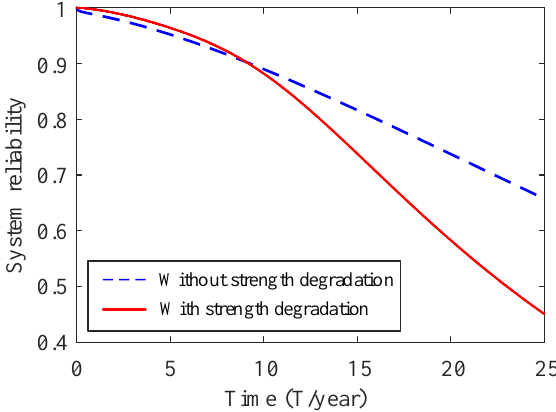
Figure 16. System reliability considering strength